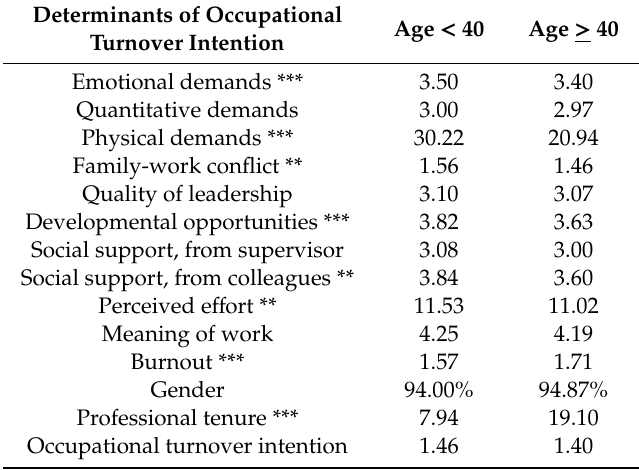
Table 2. Means and Significant Di ff erences by Age Group.